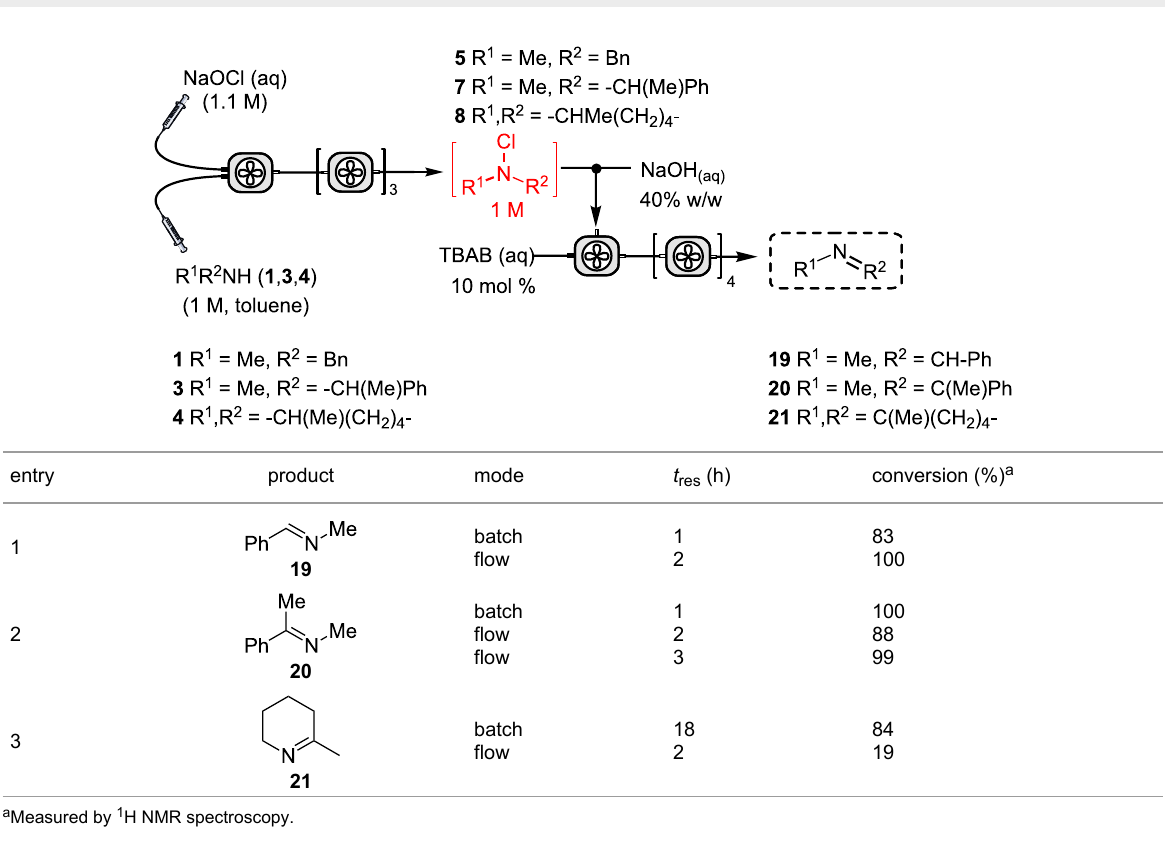
Table 5: Batch vs flow study of the dehydrochlorination